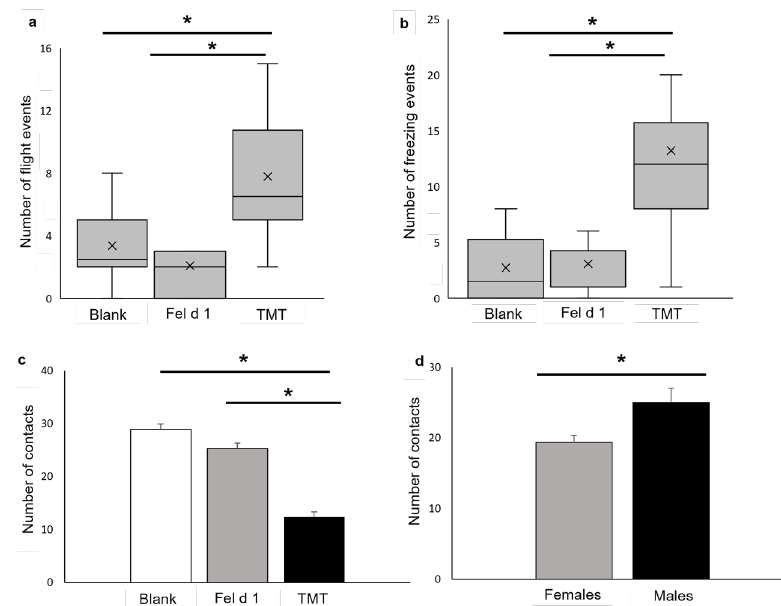
Figure 7. ( a ) Number of flight events; ( b ) number of freezing events. Number of contacts with the treatment: ( c ) effects of treatment; ( d ) effects of sex. Statistical analysis was performed Scheirer-Ray-Hare test ( a , b ) and with ANOVA and Lsmeans ( c , d ). The significance threshold is fixed at 5%. n.s, non-significant. p < 0.05 *.